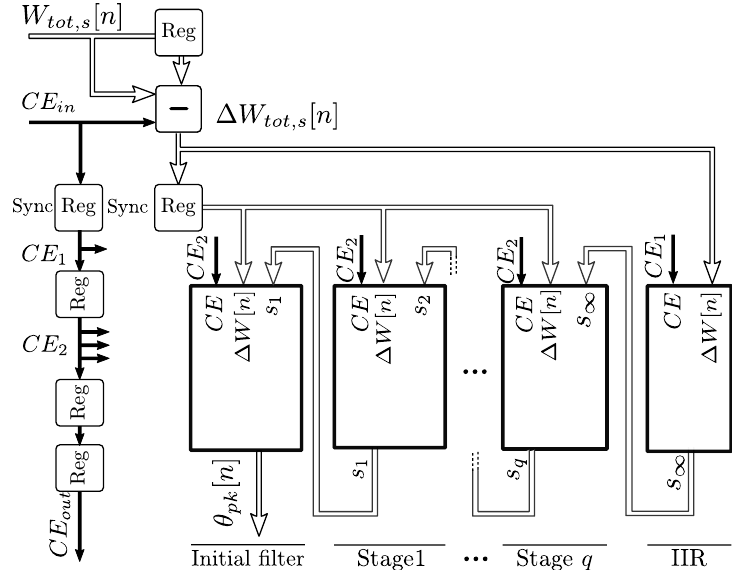
Figure 8. Complete pipelined hardware logic implementation of the mutual heating and soil effect